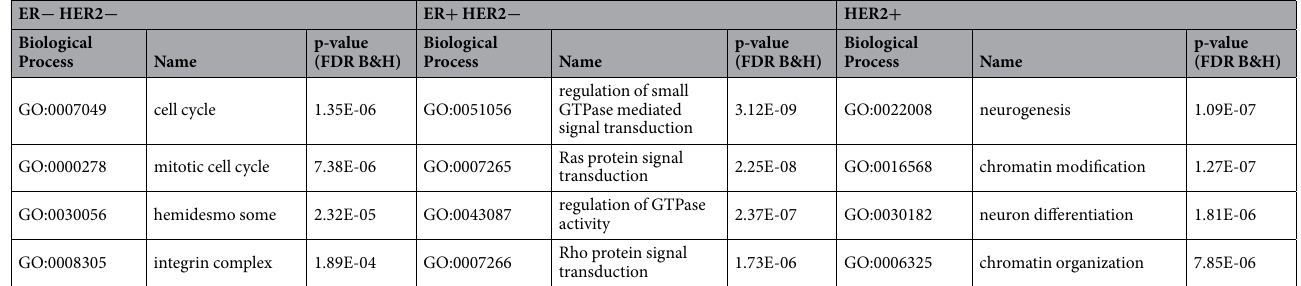
Table 5. Significantly enriched biological processes and pathways affected by subtype specific alternative exon